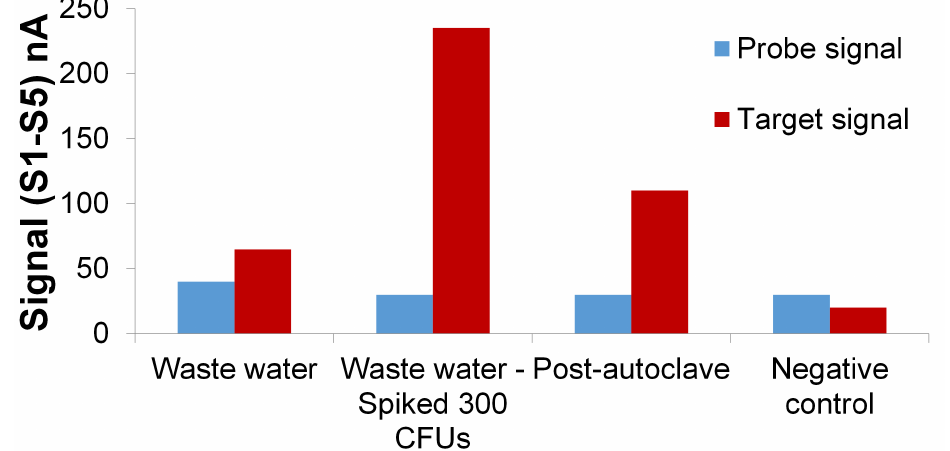
Figure 9. Electrochemical signal corresponding to E. coli O157:H7 in waste water effluent samples. Negative control is in the form of DI water without any E. coli O157:H7 in it. EC measurement condition: pulse size: 20 mV, scan rate: 5 mV/s, scan range 0.5 V to 1.2 V ( vs. Ag/AgCl reference electrode). Supporting electrolyte: 0.2 M acetate buffer solution (pH 5) containing 5 µ M Ru(bpy) 2+ 3